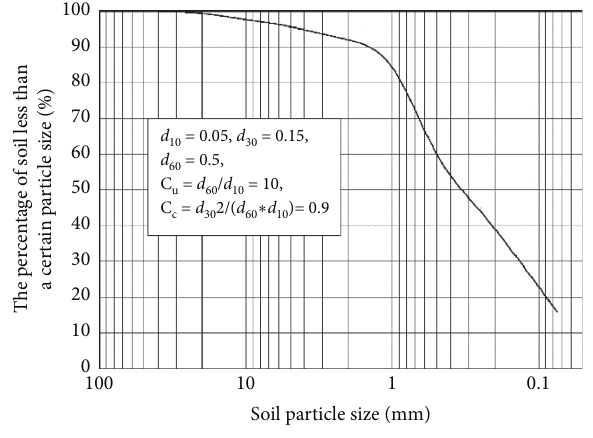
Figure 1: Grain size distribution curve of soil. Table 1: Basic physical properties of loess